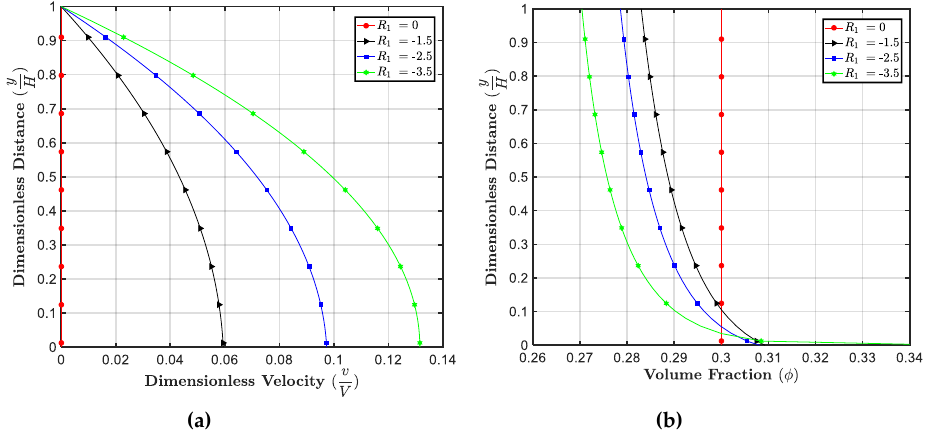
Figure 12. E ff ect of R 1 on ( a ) the velocity; and ( b ) the volume fraction profiles, with β = 1.82, φ avg = 0.3, Figure 12. Effect of 𝑅 1 on ( a ) the velocity; and ( b ) the volume fraction profiles, with 𝛽 = 1.82, 𝜙 𝑎𝑣𝑔 =